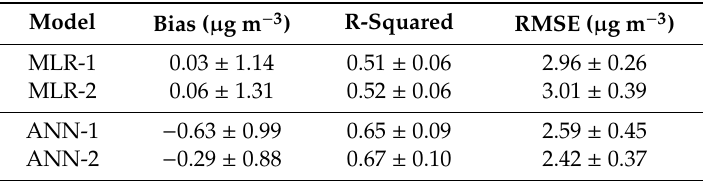
Table 3. Averaged statistical scores of four models at 21 selected